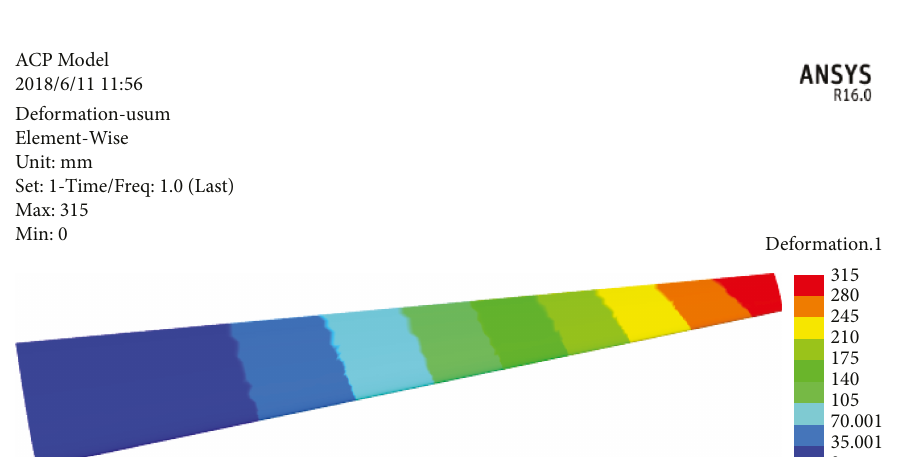
Figure 60: Stress cloud diagram of full-metallic wing.